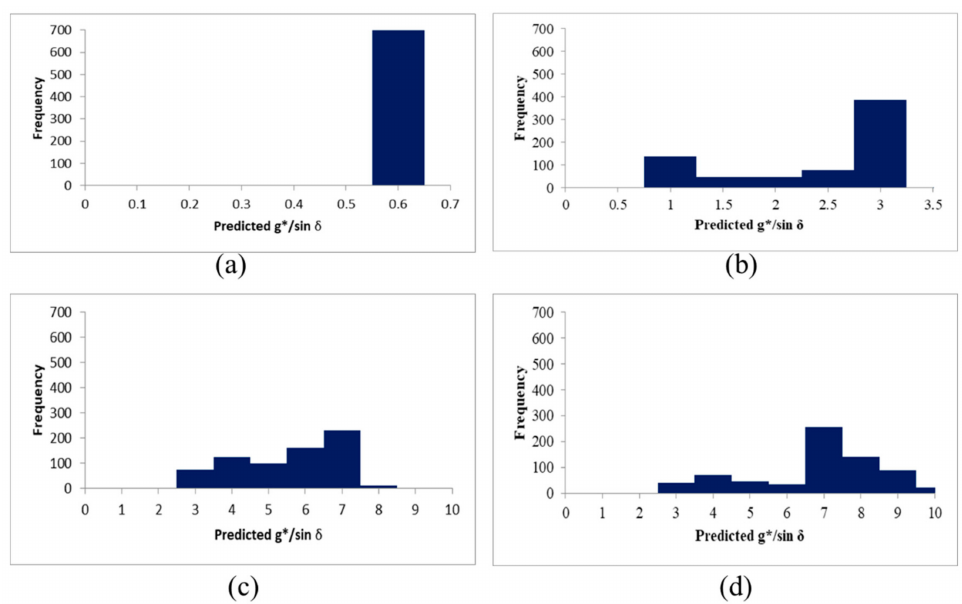
Figure 17. Distributions of the predicted value; ( a ) images whose actual value is 0.51, ( b ) images whose actual value is 2.72, ( c ) images whose actual value is 6.61, ( d ) images whose actual value is